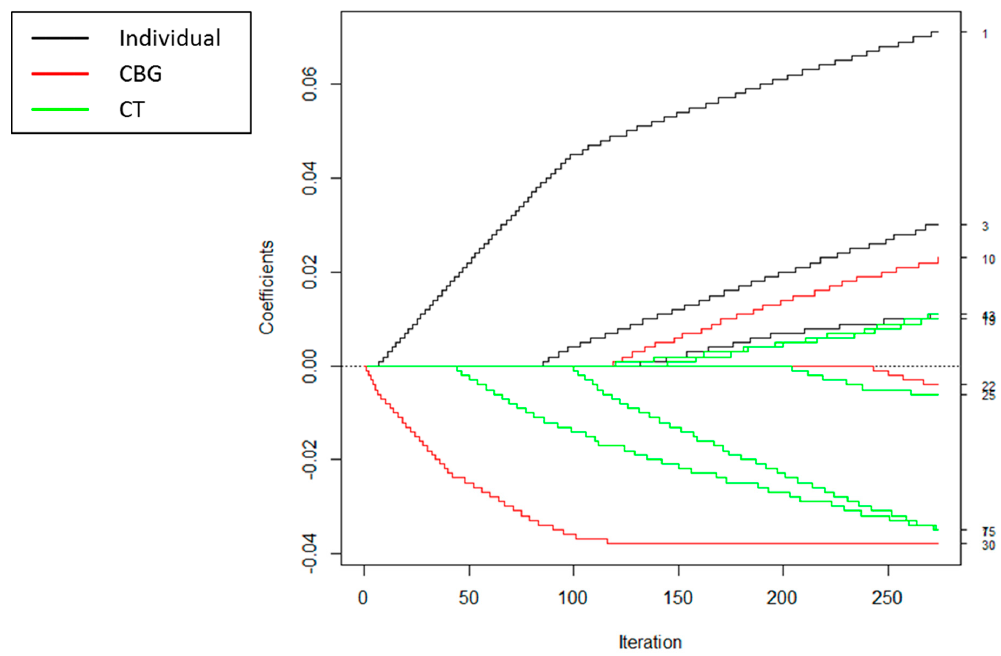
Figure 3. Coefficient paths for spatial scale incremental forward stagewise regression to explain BMI z-scores. The scale at which each covariate entered the model is indicated by the legend. The numbers on the right-hand side of the figure are the variable numbers listed in Table 1.